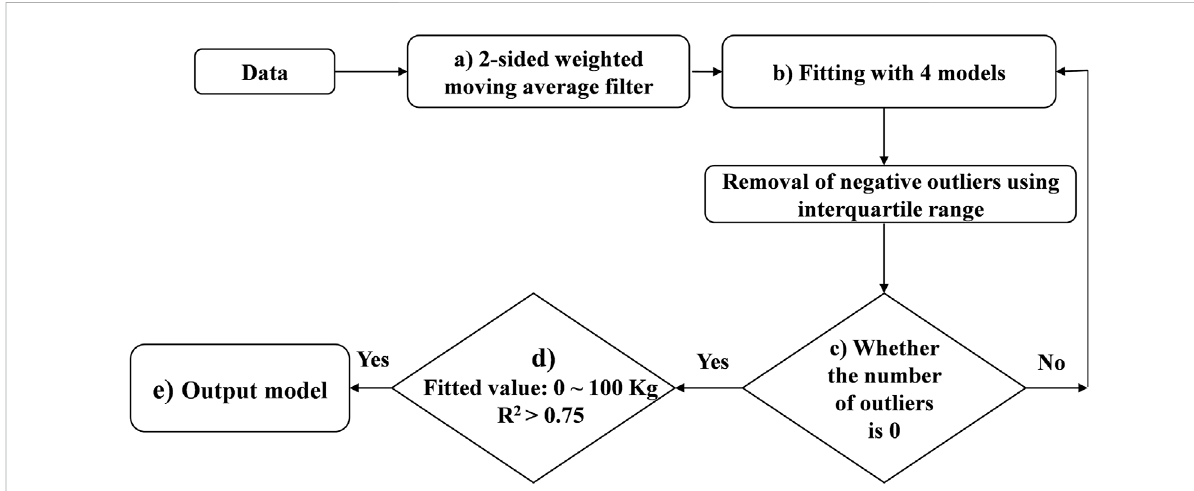
FIGURE 2 Illustrative scheme of the process of fi tting the expected lactation curve (ELC).